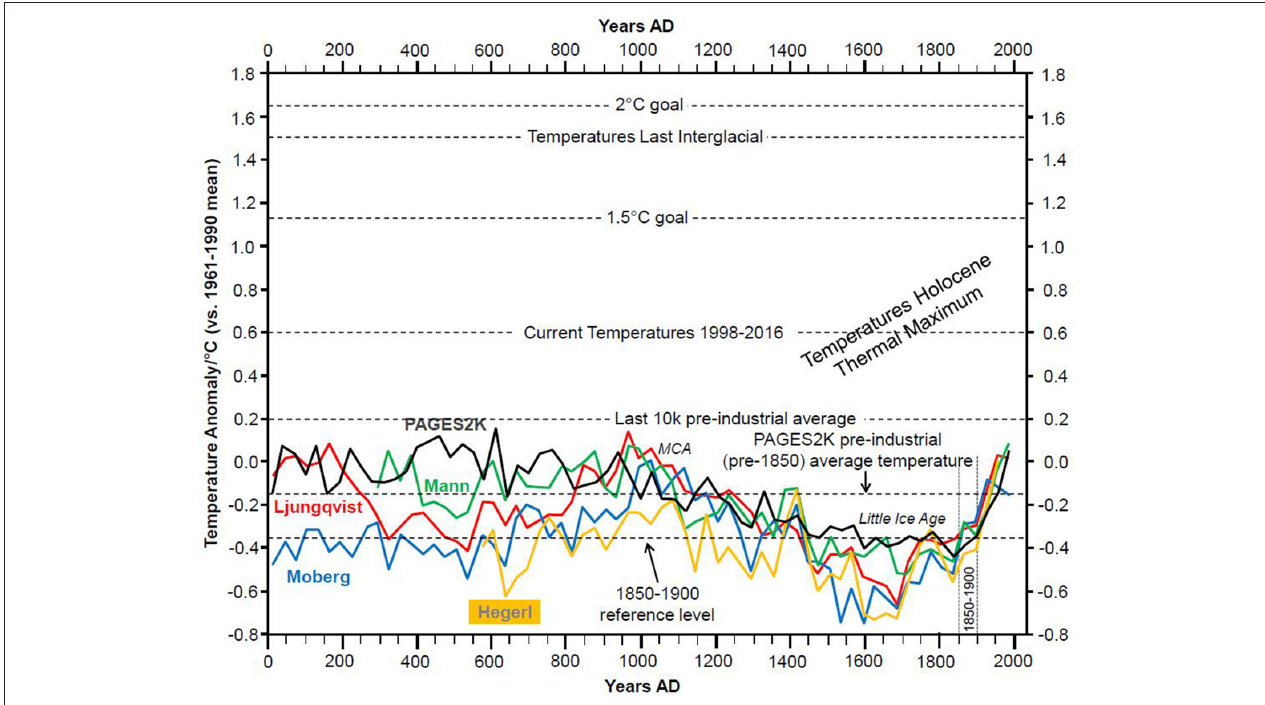
FIGURE 2 | Temperature reconstructions for the past 2,000 years (Moberg et al., 2005; Hegerl et al., 2007; Mann et al., 2008; Ljungqvist, 2010; PAGES 2k Consortium, 2013 : area-weighted averages) compared to important reference levels. Average pre-industrial temperature for last 10,000 years (“last 10 k”) after Marcott et al. (2013). Average temperatures of Last Interglacial after Turney and Jones (2010). MCA, Medieval Climate Anomaly. Main temperature curves illustration adapted from PAGES 2k Consortium (2013), used with permission from Nature Publishing Group.